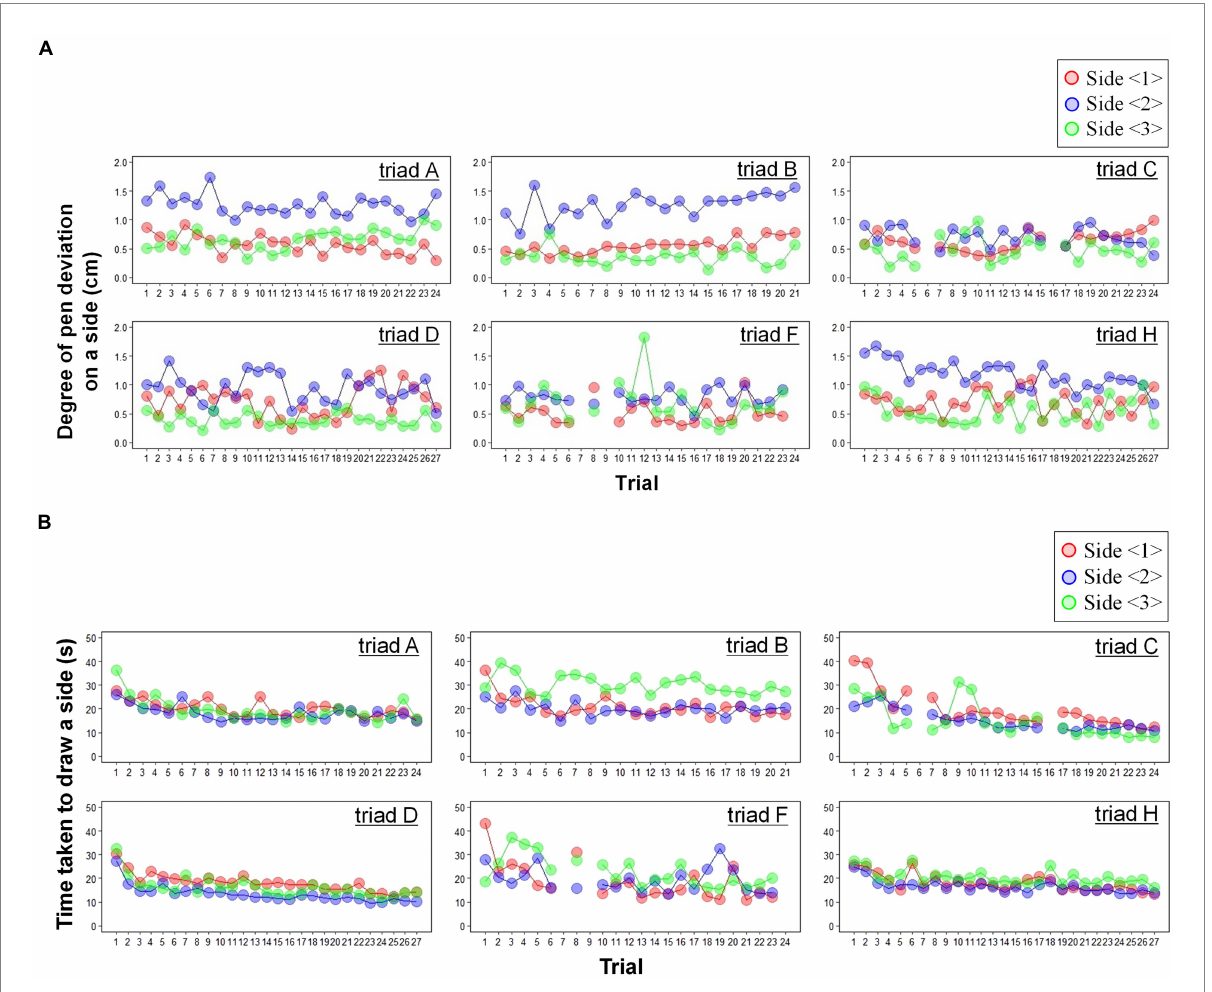
FIGURE 5 Time series of task performance. (A,B) Show the degree of pen deviation on a side (cm) and the time taken to draw a side (s) through trials, respectively. There are missing data due to measurement problems, such as thread breaking. The triads drew the triangle quickly through trials while maintaining a certain degree of pen